Question: What form of chart is displayed?
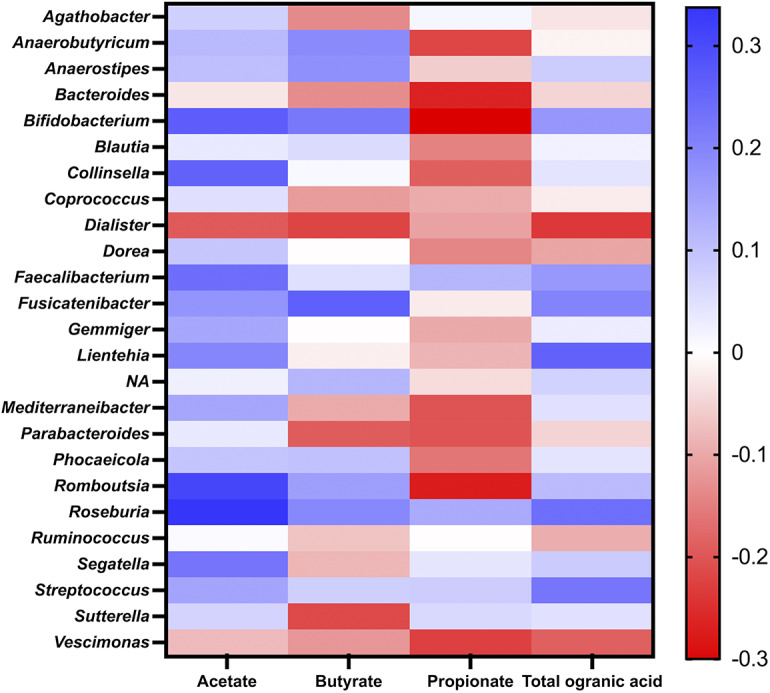
Answer: heatmap